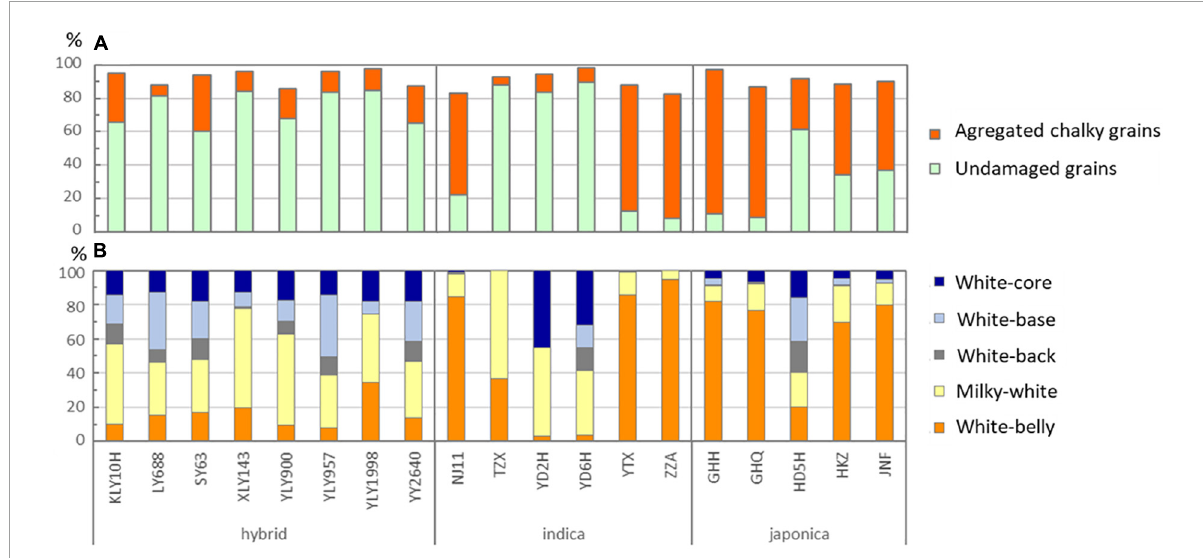
FIGURE1 Fractions of undamaged grains and aggregated chalky grains (A) , and fractions of various chalkiness types in the aggregated chalky grains (B) by cultivar and rice type on average across the EDU and Control treatment